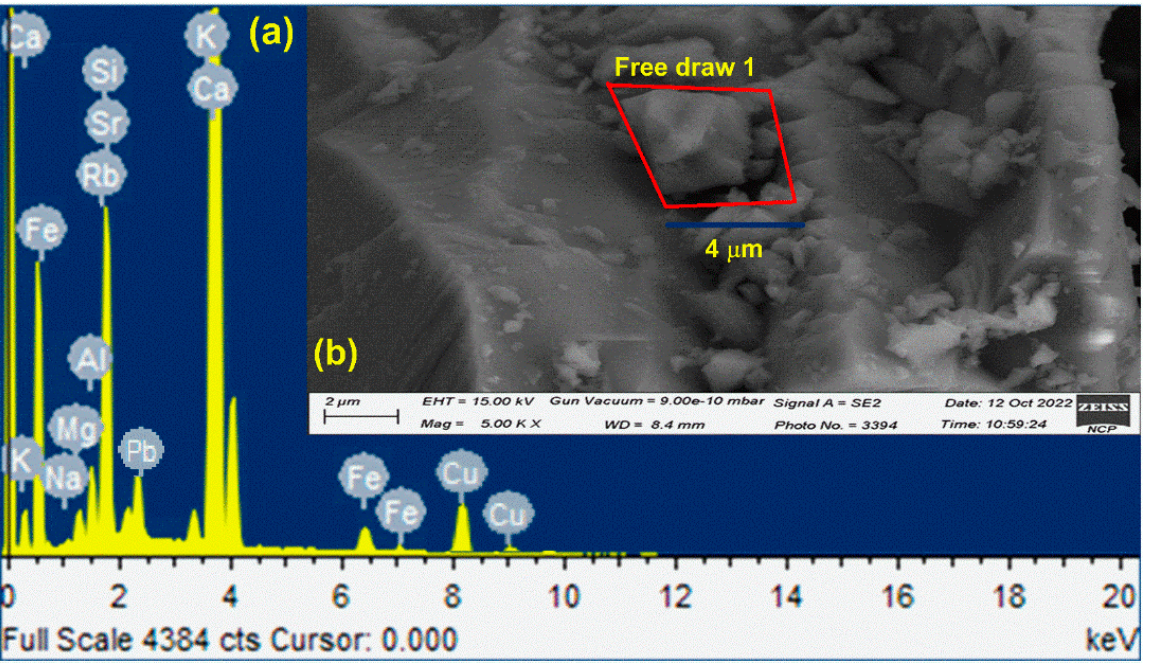
Figure 10. ( a ) EDX spectrum of the P. harmala seed sample-( α ) at 30 keV; ( b ) SEM image of the P. harmala seed sample-( α ) showing the surface morphology.